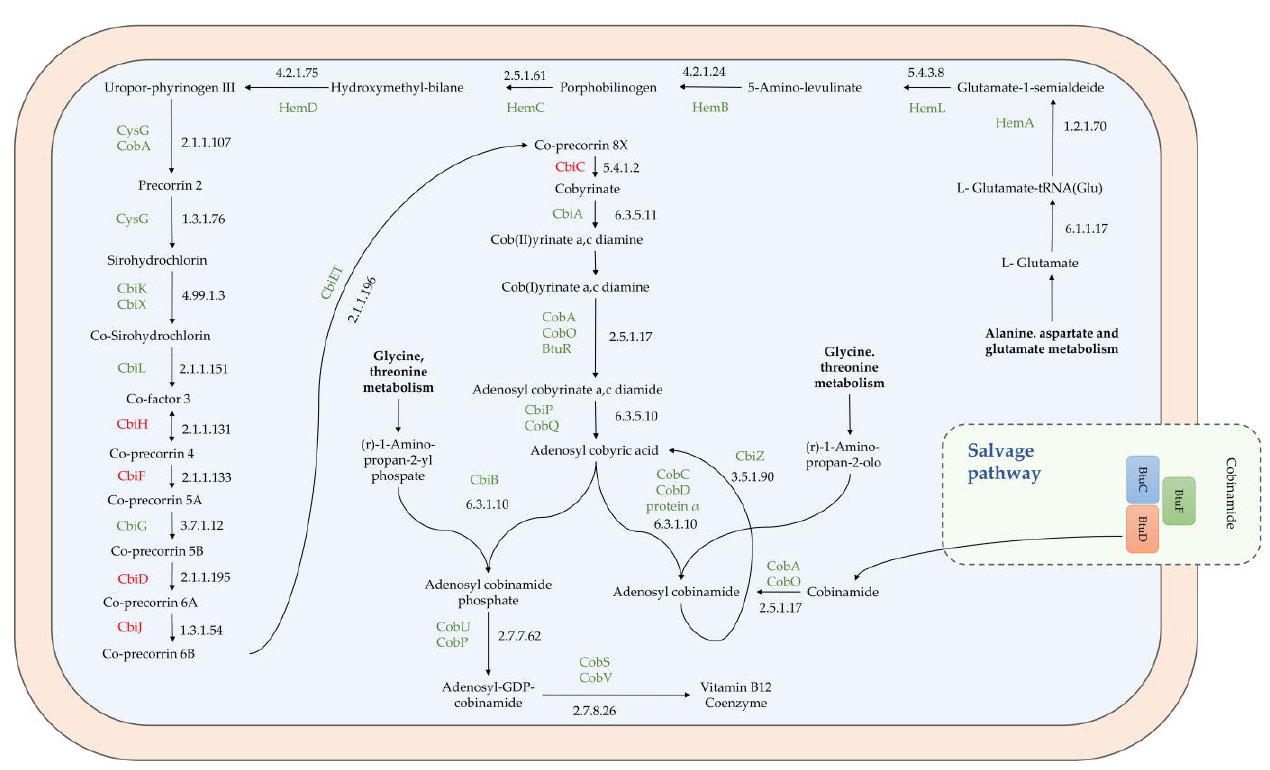
Figure 4. Vitamin B12 coenzyme pathway. Genes present in the food-isolated H. salinarum strains are highlighted in green, whereas, in red, absent genes are evidenced based on the general KEGG porphyrin pathway.